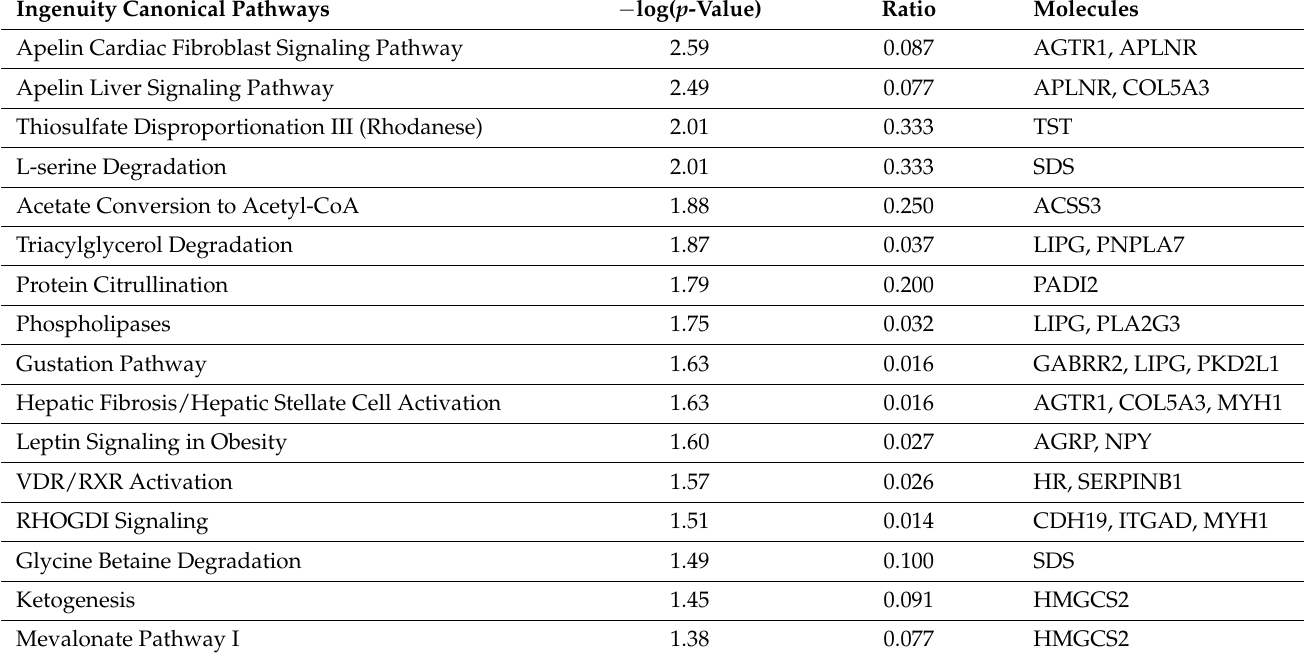
Table 3. Top 16 canonical pathways of differentially expressed genes in fasted mice compared with those of fed mice. The top 16 ( p < 0.05) results of canonical pathway analyses are listed. Canonical pathways are identified with an input of 70 DEGs in only the hypothalamus (FDR ≤ 0.05